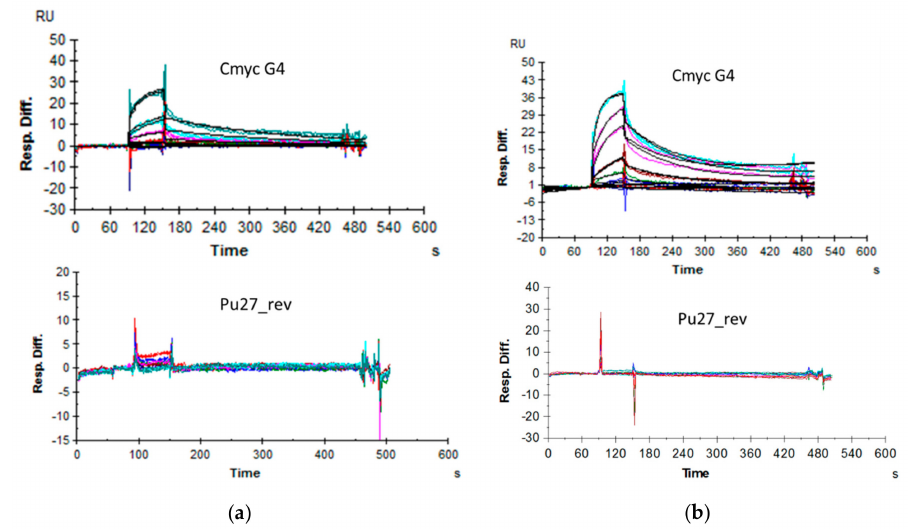
Figure 6. Surface Plasmon Resonance data. Sensorgrams recorded using a Biacore 3000. Biotinylated compounds were immobilized on a streptavidin chip, with solution-phase nonbiotinylated DNA as the analyte. ( a ) Compound 1 ; c-myc G4 Langmuir 1:1 k a = 4.25 × 10 3 ; k d = 4.46 × 10 − 3 , Rmax 15.4, K D = 1.05 uM, chi 2 = 0.643; Pu27rev no binding; ( b ) Compound 2 ; c-myc G4 Langmuir 1:1 k a = 2.83 × 10 4 ; k d = 9.29 × 10 − 3 , Rmax 28, K D = 328 nM, chi 2 = 0.511; Pu27rev no binding. Measurements were